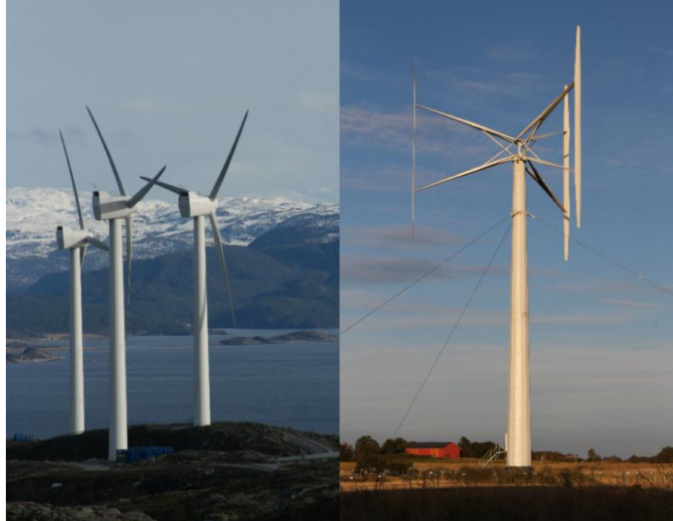
Figure 4. ScanWind and Vertical Wind. Left: ScanWind 3.5-MW turbines at Hundhammerfjellet, Norway. Photo by and used with permission from Anders Wickström. Right: The 200-kW Vertical Wind H-rotor in Falkenberg. Photo by Erik